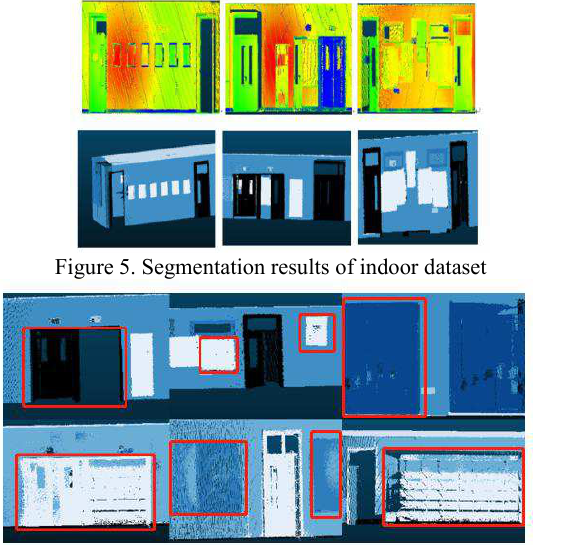
Figure 6. Comparison of Reflective including intensity